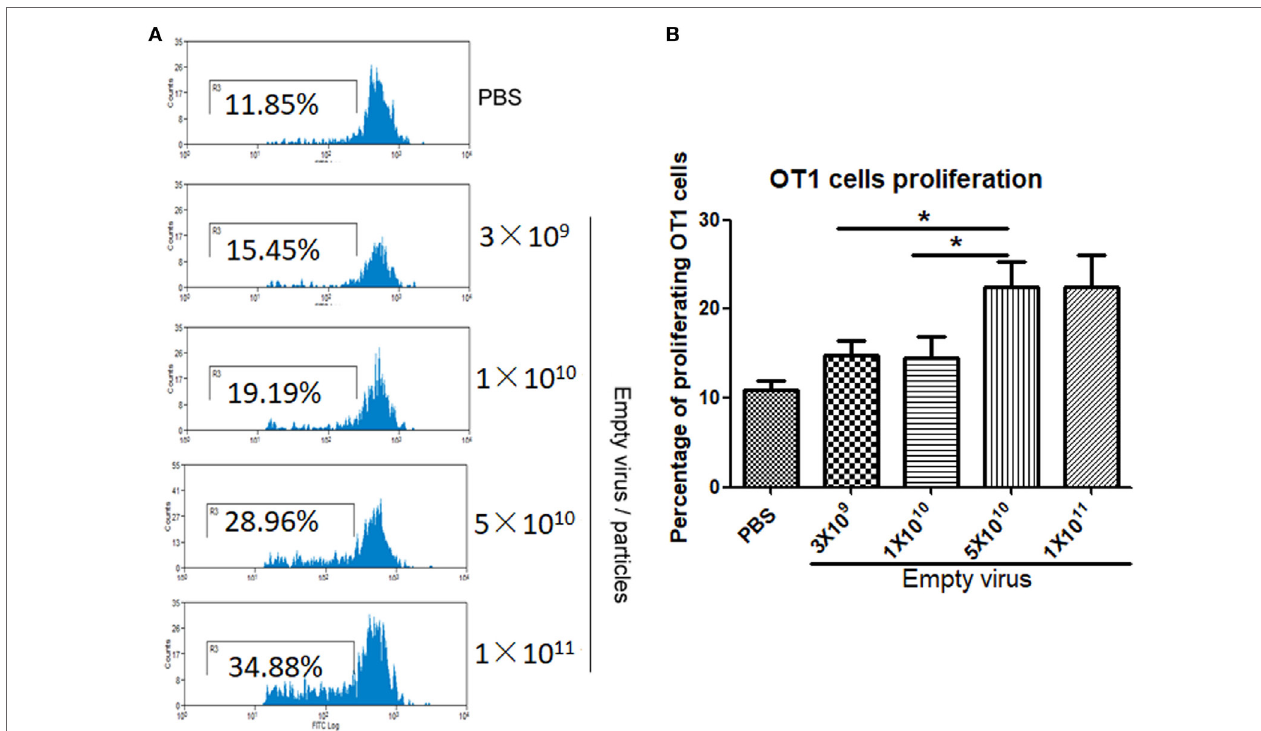
FigUre 4 | Capsid antigen presentation from AAV2OVA empty virions is dose responsive in vivo . Different doses of AAV2OVA empty vectors were intravenously injected into C57BL/6 mice and 3 days later, and CFSE-labeled OT-1 T cells were transferred into the mice. At day 10 post injection of OT-1 cells, T cell proliferation in the spleen was analyzed via flow cytometry. (a) Representative flow cytometric histograms. (B) Average T cell proliferation and SD of five mice. * p < 0.05 when compared to mice with the low dose of AAV treatment.